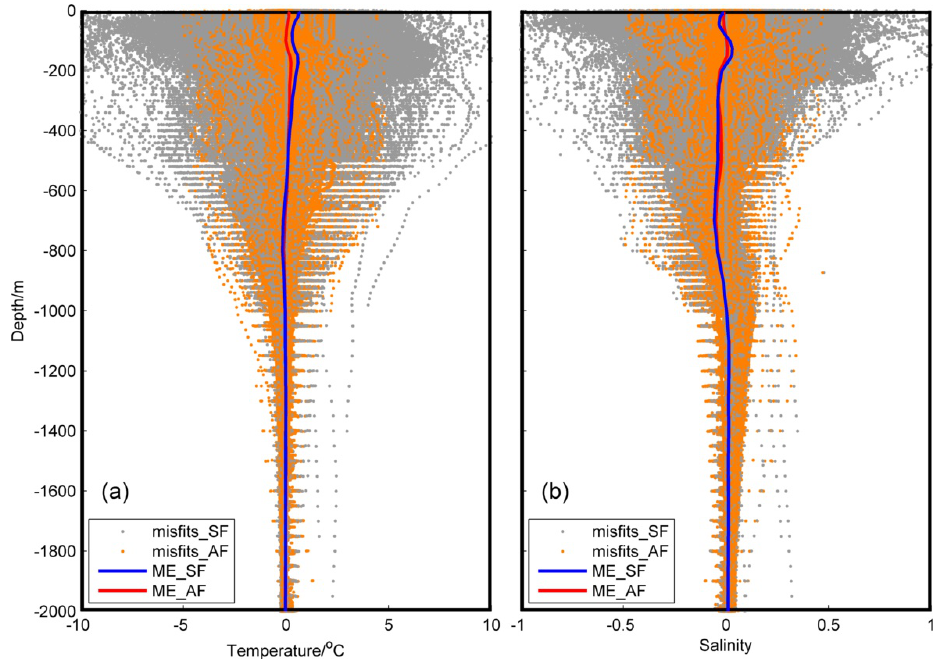
Figure 4. Vertical distribution of misfits for temperature ( a , in ◦ C) and salinity ( b , in psu): the red line represents the AF bias, the black line represents the SF bias, the orange dotted line represents the misfits of AF and the gray dotted line represents the misfits of